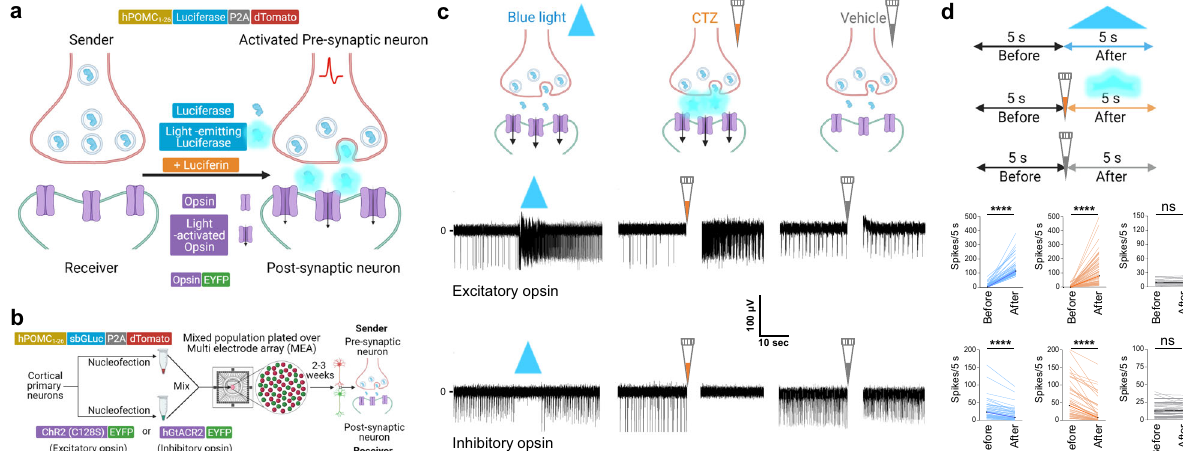
Fig. 2 Modulation of postsynaptic neural activity by Interluminescence in mixed cultures of pre- and postsynaptic neurons. a Schematic: Interluminescence via an Optical Synapse. Luciferases (blue colored enzyme inside the gray circles) are released from presynaptic vesicles and, in the presence of the luciferin, emit light (bioluminescence: light bluish glow) that activates postsynaptic opsins (magenta; downward black arrows indicating ion movement through open channels). b Schematic of experimental design and constructs used for separate nucleofections of cortical neurons with either hPOMC1-26-sbGLuc-P2A-dTomato or one of the opsins, ChR2(C128S)-EYFP (excitatory) and hGtACR2-EYFP (inhibitory); neurons were then mixed (red and green spheres), plated on MEAs and maintained for 2 – 3 weeks until recording. c Illustrations (upper panels) and corresponding representative traces from individual electrodes of MEAs (middle and lower panels) showing response of postsynaptic neurons to blue light (blue solid triangle), CTZ-induced bioluminescence (orange pipette tip) and vehicle (gray pipette tip) expressing the excitatory opsin ChR2(C128S) (middle panels) and the inhibitory opsin hGtACR2 (lower panels). d Schematic showing the time windows for analyzing the number of spikes for each treatment (upper panel) and ladder plots from multiple experiments (middle panels for excitatory and lower panels for inhibitory opsin-expressing postsynaptic neurons as depicted for individual traces in ( c ). ChR2(C128S), blue light, n = 62, p < 0.0001, CTZ, n = 62, p < 0.0001, vehicle, n = 24, p = 0.6498; hGtACR2, blue light, n = 49, p < 0.0001, CTZ, n = 49, p < 0.0001, vehicle, n = 49, p = 0.5594; Wilcoxon matched-pairs signed rank test. The artifacts due to addition of reagents in MEAs are overlaid by a vertical white bar in all MEA recording traces (the white gap right after addition of either CTZ or vehicle). ns, not signi fi cant; **** p <